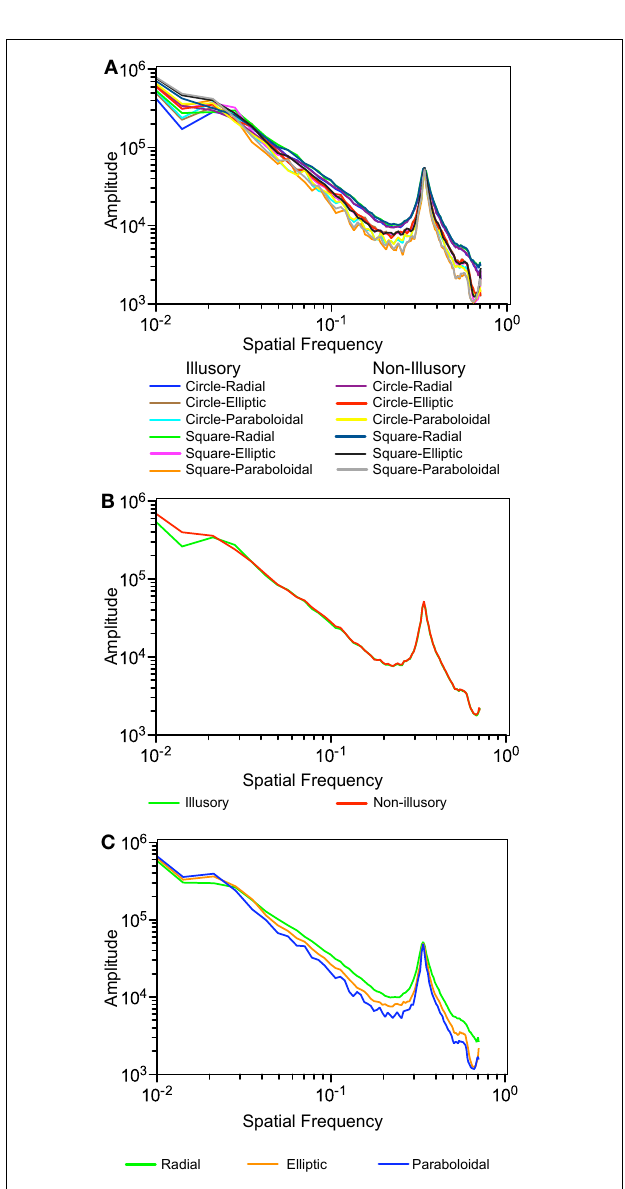
FIGURE 10 |Amplitude spectra of Spatial Frequency: (A) individual stimuli (B) averaged for the Illusory vs. Non-illusory stimuli (C) averaged for the three types of the Inner Layout.